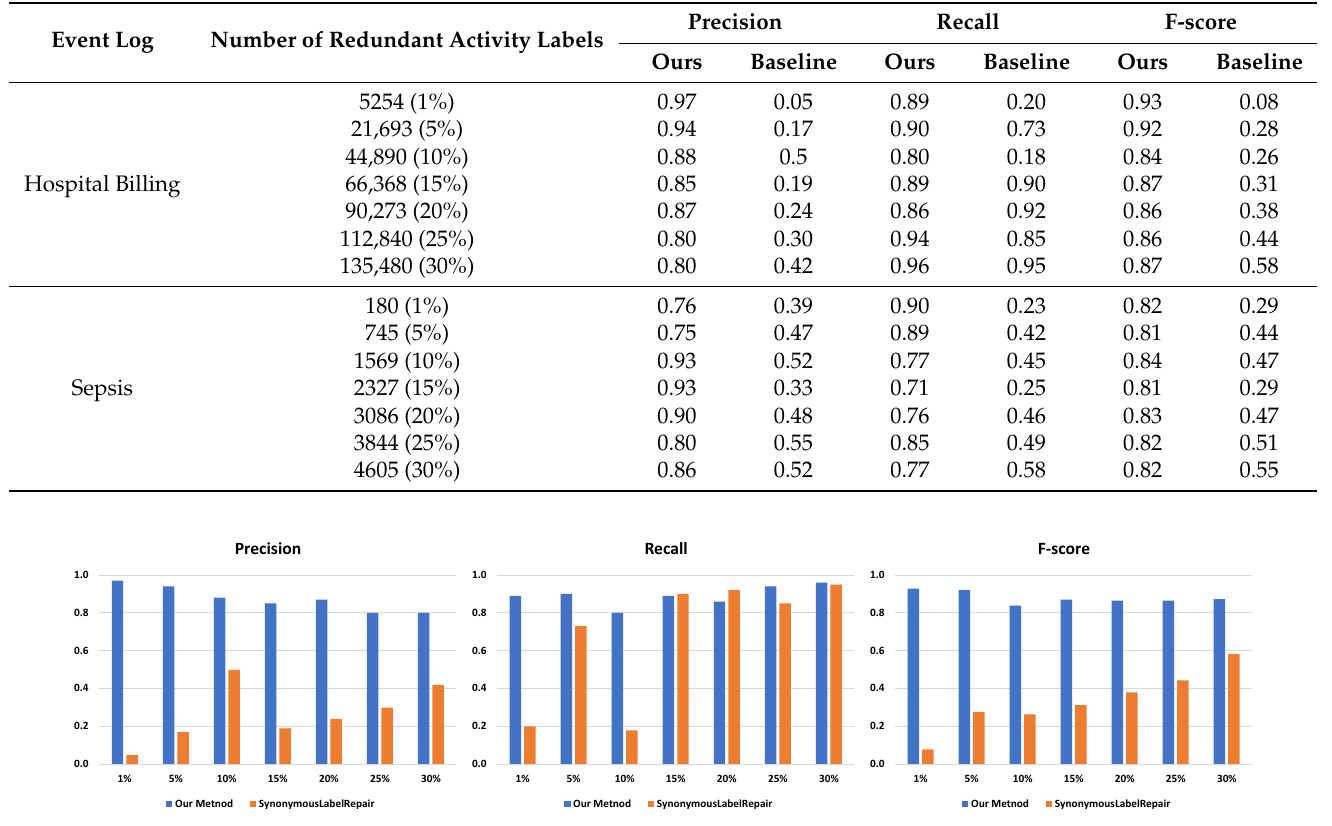
Figure 6. Comparison of our framework with the baseline using the Hospital Billing event log.